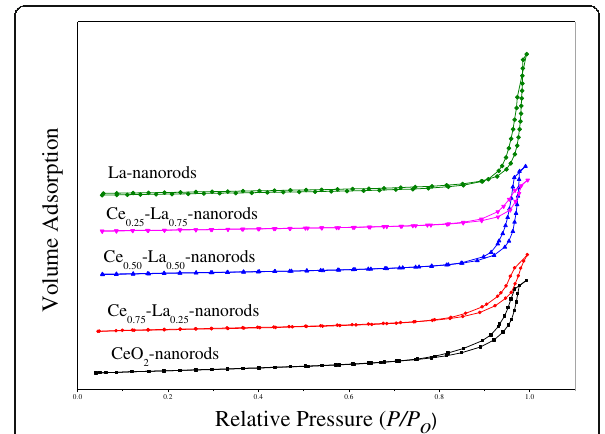
Fig. 1 Nitrogen adsorption-desorption isotherms of Ce-La nanorods with different La content